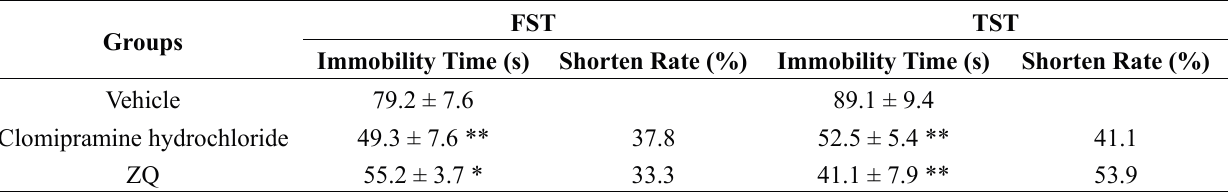
Table 2. Effect of ZQ on FST and TST in mice (mean ± SD) ( n = 10).